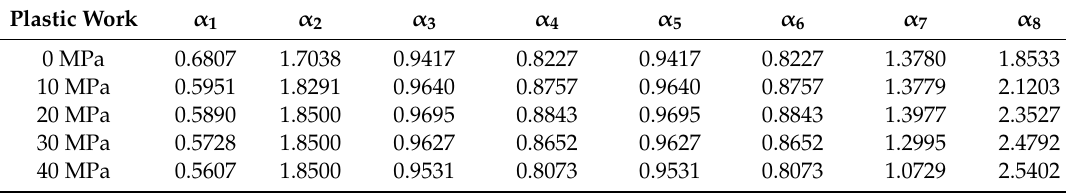
Table 6. Calibrated parameters for the plastic potential function of the niobium sheet for every 10 MPa increments of the plastic work ( m = 6).